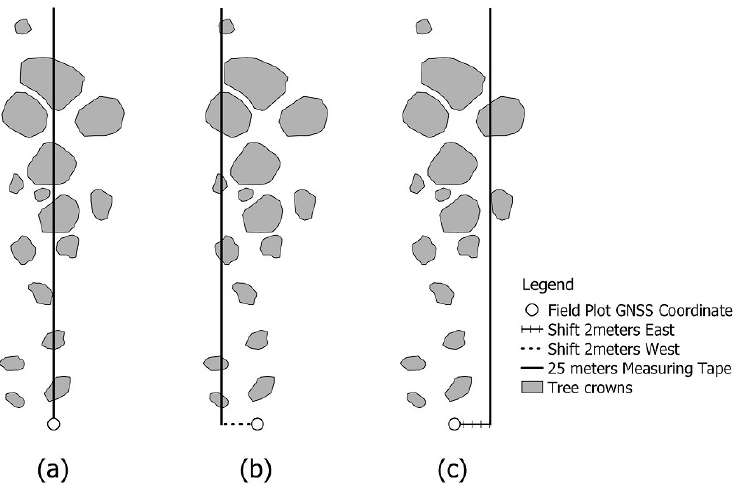
Figure A2. An experiment to quantitatively measure the influence of the measuring tape position in Vegetation Cover acquisition if trying to replicate the fieldwork procedures on RPA imagery. Vegetation Cover value from the middle longitude of the field plot, which is where the measuring tape is positioned in the fieldwork procedures, ( a ) was compared to the Vegetation Cover value when moving the measuring tape 2 m in the west direction ( b ) and the east direction ( c